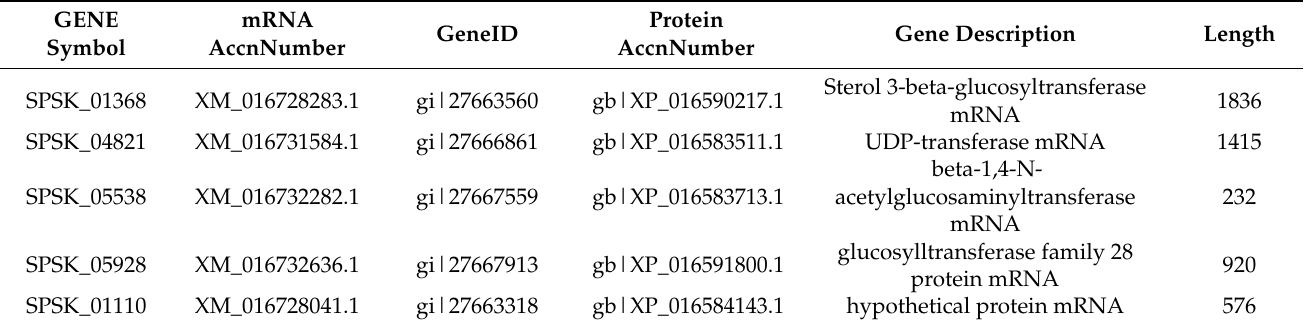
Table 1. Genes of putative rhamnosyltransferases identified on the Sporothrix schenckii